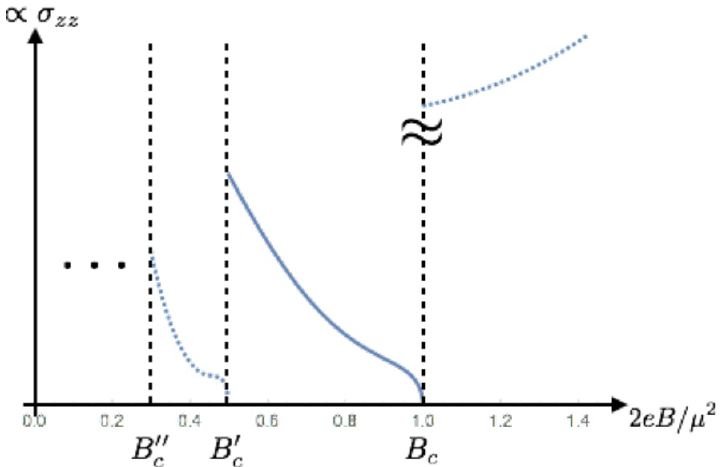
Figure 4 . The magnetic (cid:12)eld dependence of the conductivity: (cid:27) zz vs. 2 eB=(cid:22) 2 . The solid line is our result, where our computation is safely applied in the range B 0 intra-cone transition is forbidden for a massless fermion, only the inter-cone transition contribute to the suppression of the conductivity. When B < B 0 intra-cone